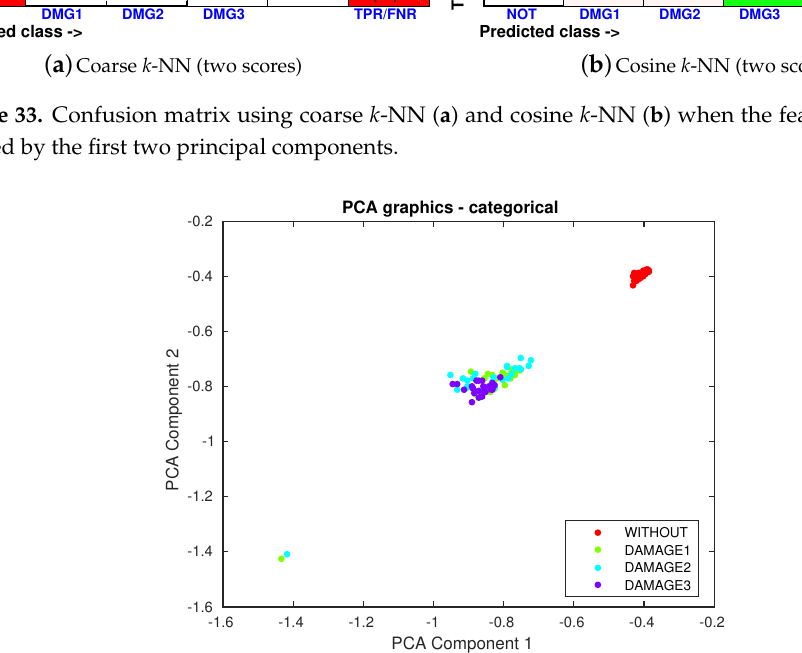
Figure 34. First principal component versus second principal component in the composite plate described in Section